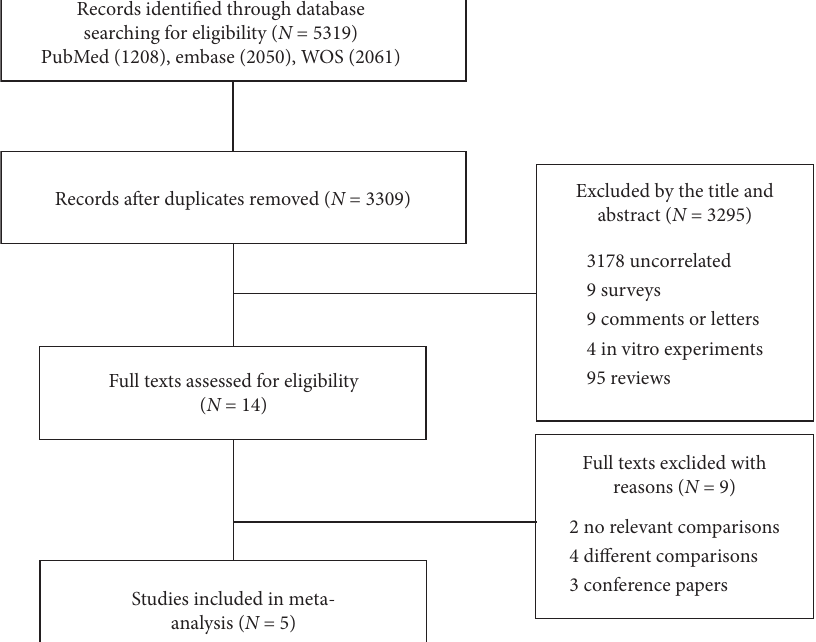
Figure 1: Flow diagram of the study identification and selection